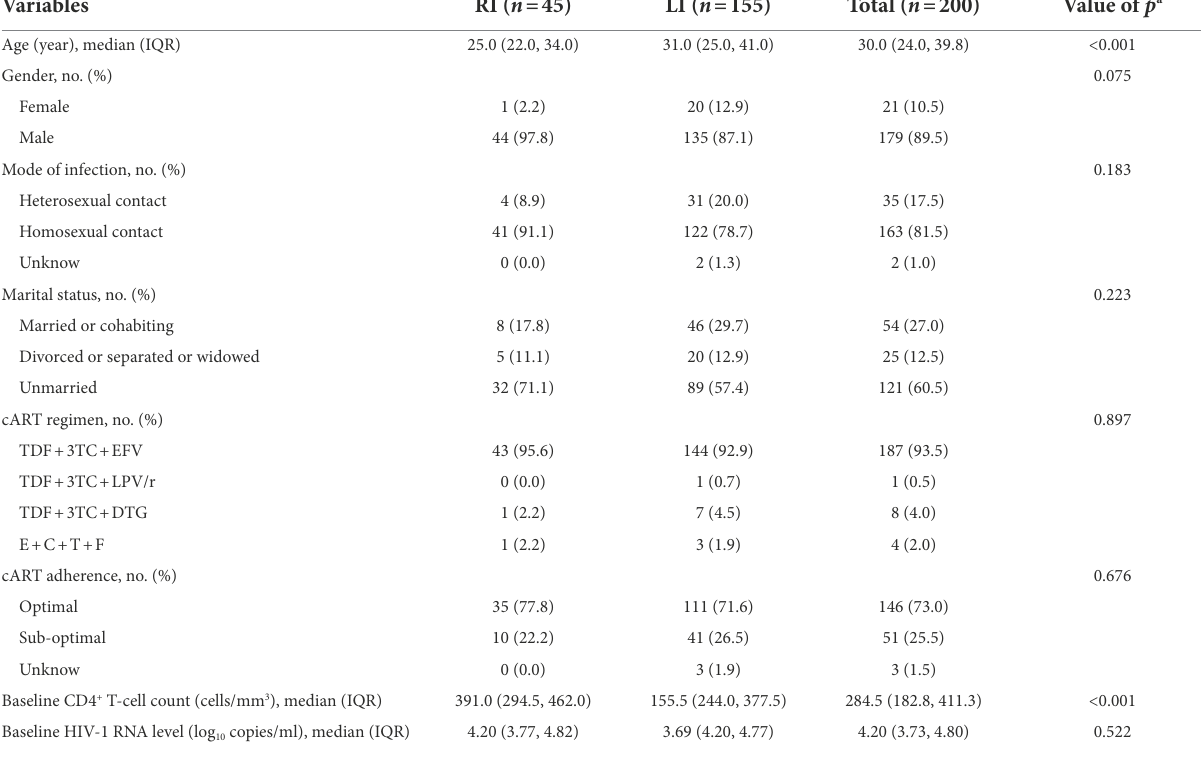
TABLE 3 Clinical and demographical characteristics of the study cohort. Variables